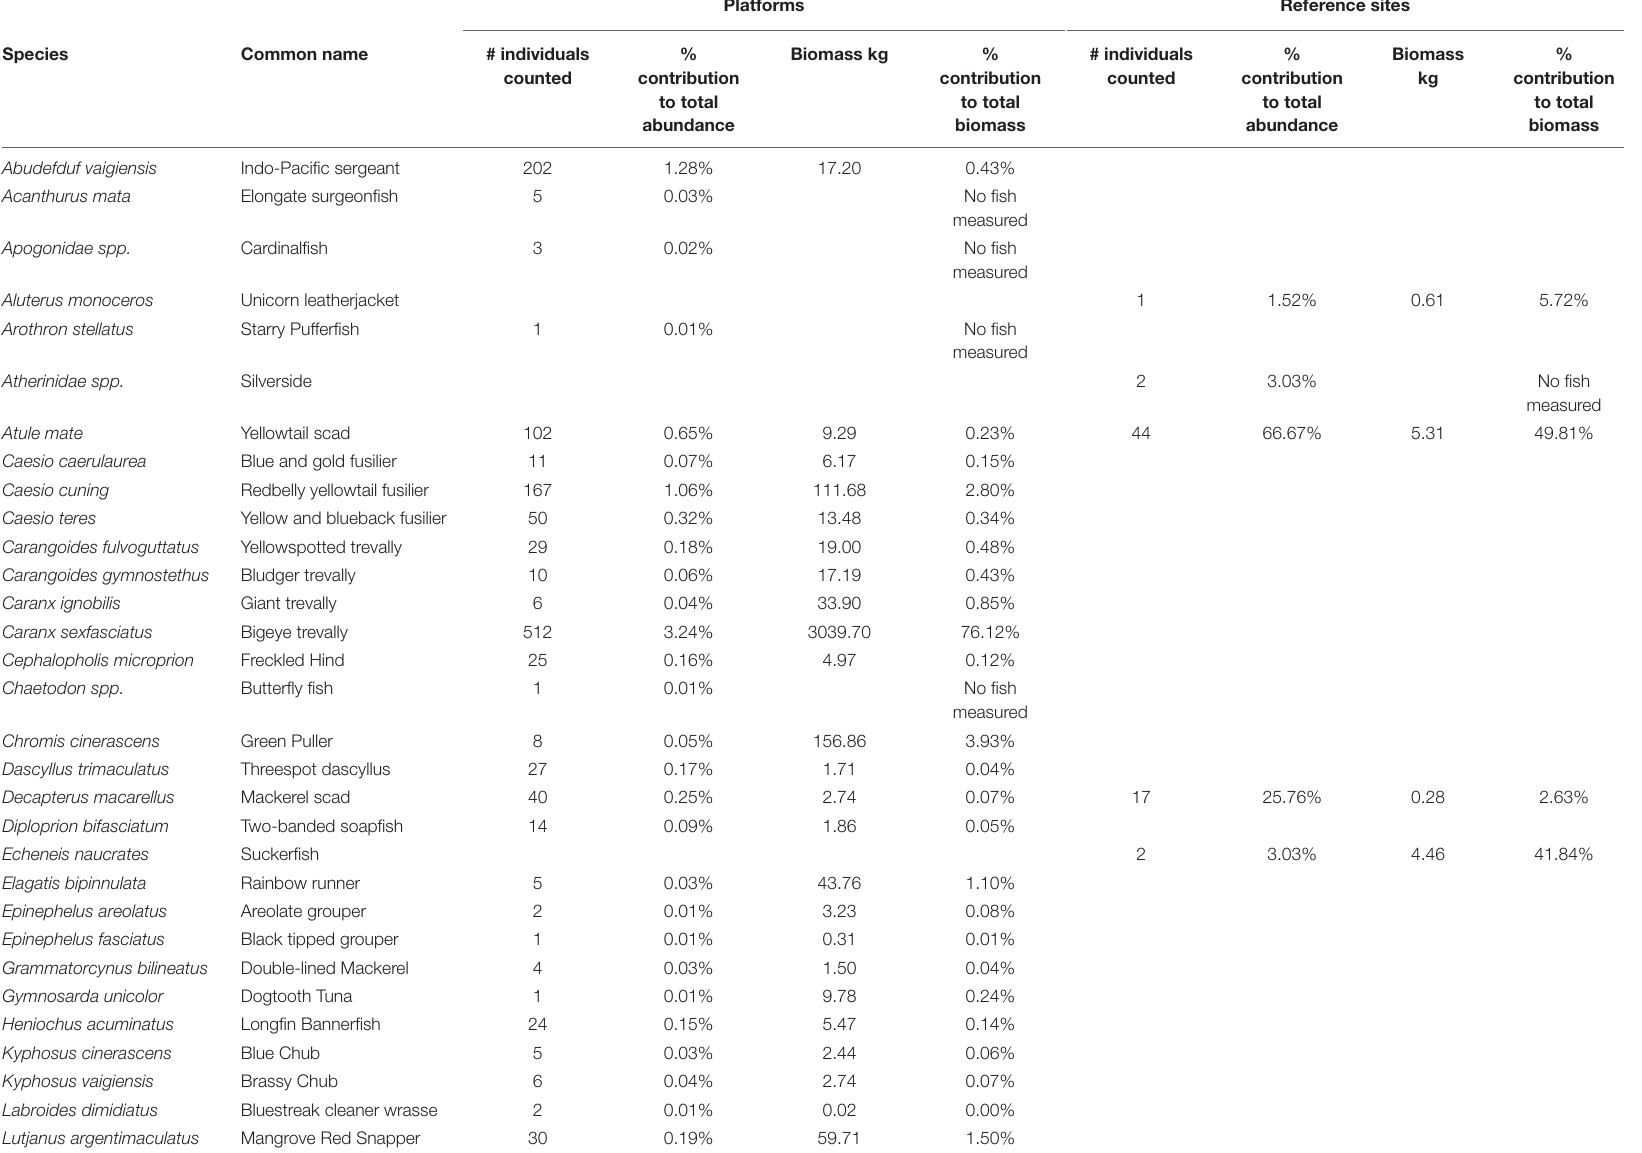
TABLE 4 | Species counts and biomass observed at Platform and Reference